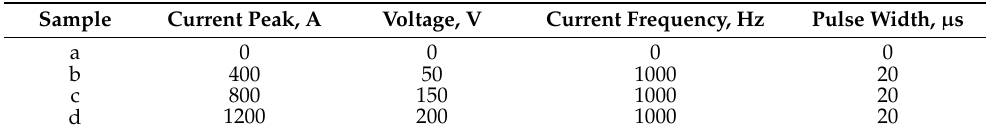
Table 2. Parameters of the pulsed current in this work.